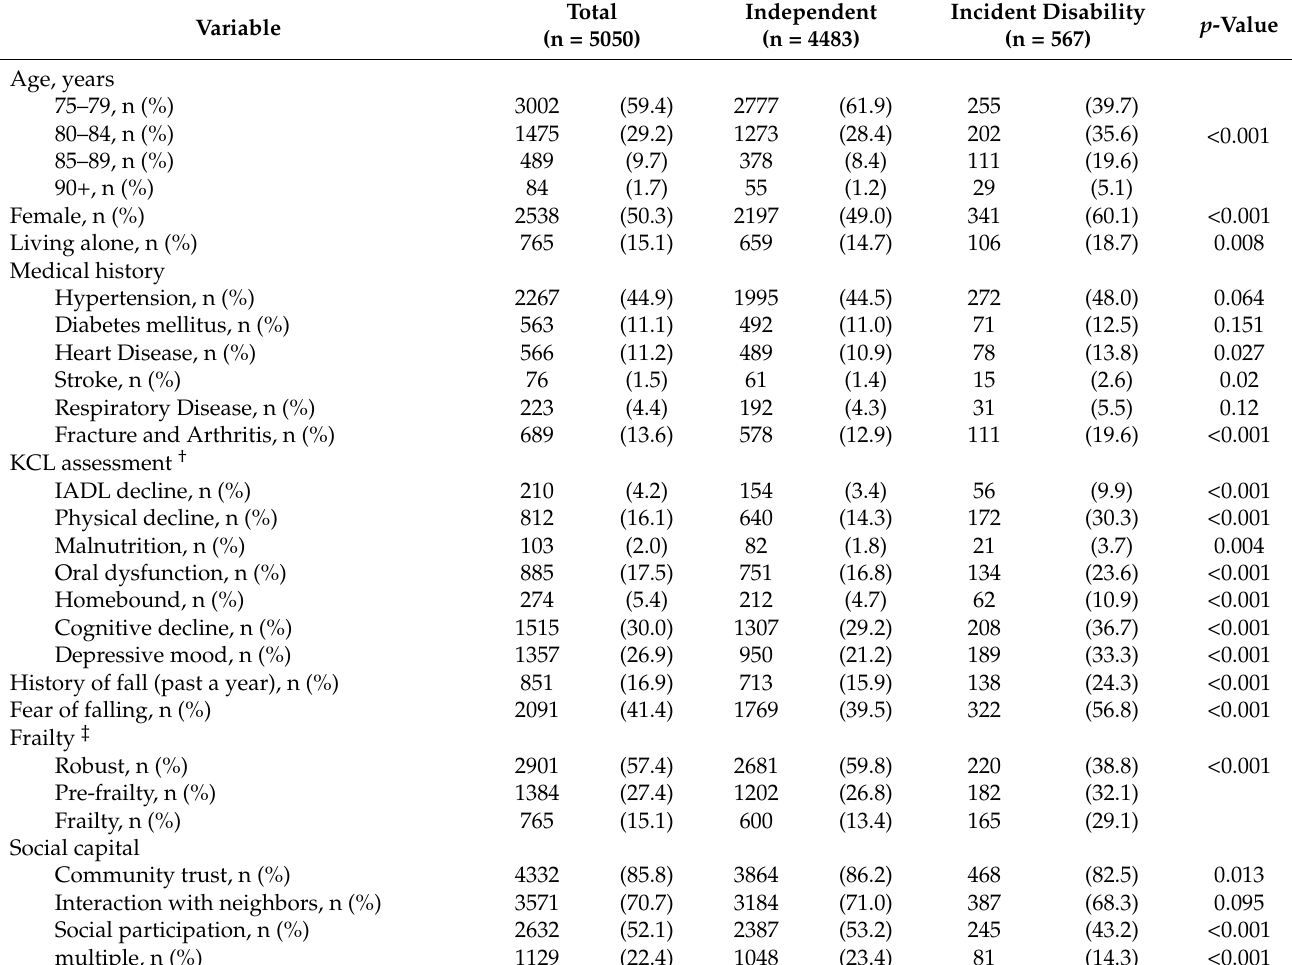
Table 1. Baseline characteristics of participants by incidence of disability over the 4 years after baseline